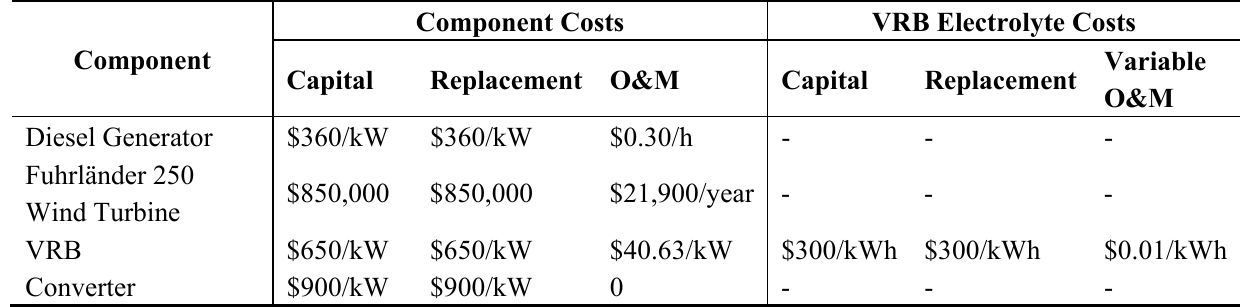
Table 3. HOMER cost input